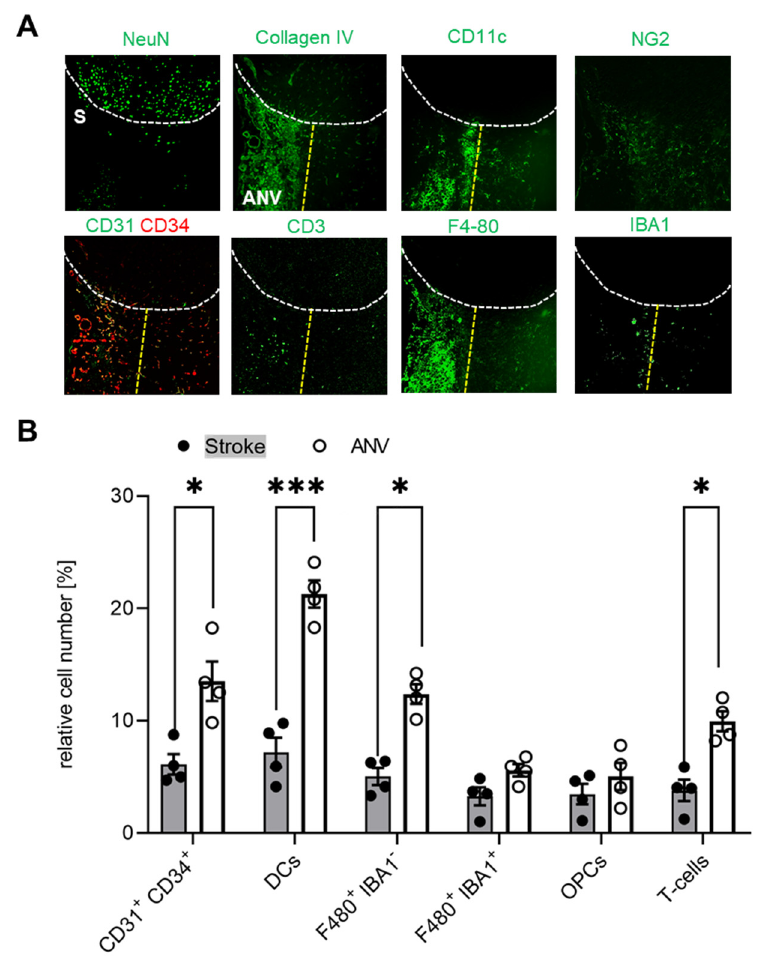
Figure 5. Localized differences of the immune cell distribution in the stroke-affected region. ( A ) Representative MELC images of different immune cells in unaffected and stroke-affected areas (S) as well as IC-ANV 28 days after stroke induction. White dotted lines depict the borders between the three areas. The white bar represents 100 µ m. ( B ) Quantitative analysis of immune cells based on the MELC images using flow cytometry standard format in the ischemic core and IC-ANV. Data are shown as mean ± S.E.M (n = 4). Two tailed Student’s t -test * p < 0.05; *** p < 0.001.